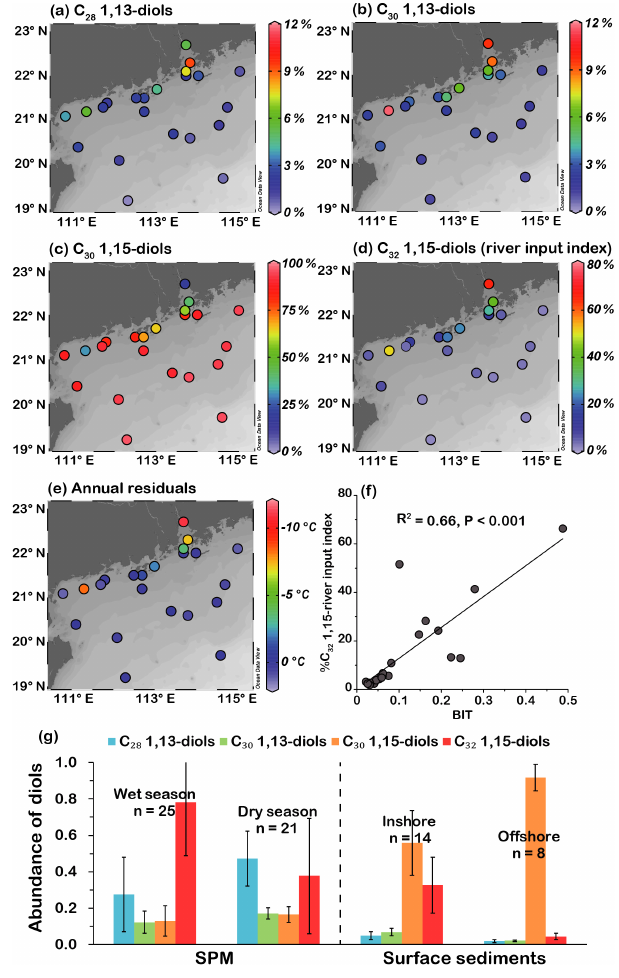
Figure 4. Spatial distribution of relative abundances of (a) C 28 1,13-diol, (b) C 30 1,13-diol, (c) C 30 1,15-diol, and (d) C 32 1,15- diol (river input index); (e) spatial distribution of annual residuals of LDI-derived SSTs; (f) relationship between BIT and %C 32 1,15 (river input index); (g) distribution of average fractional abundances of diols in SPM in the PRE (data from Zhu et al., 2018), inshore and offshore surface sediments (data from this study; error bars indicate the standard